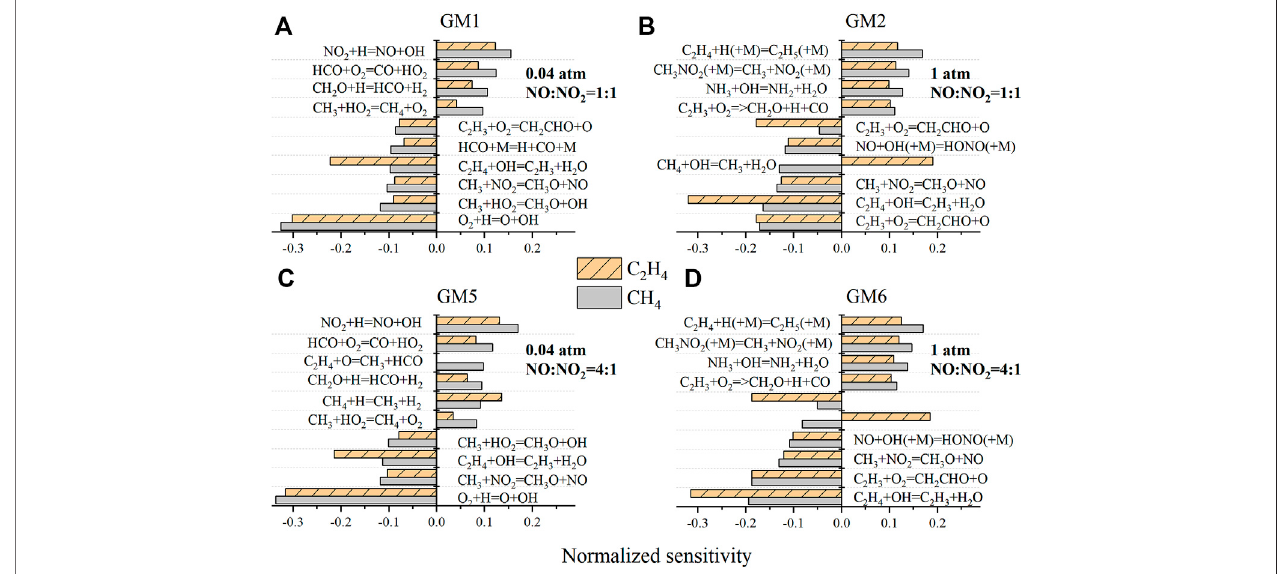
FIGURE 7 | Sensitivity analysis on CH 4 and C 2 H 4 consumption during the fl ow reactor oxidation of GM1, GM2, GM5 and GM6 at 1239, 886, 1239, and 886 K, respectively.